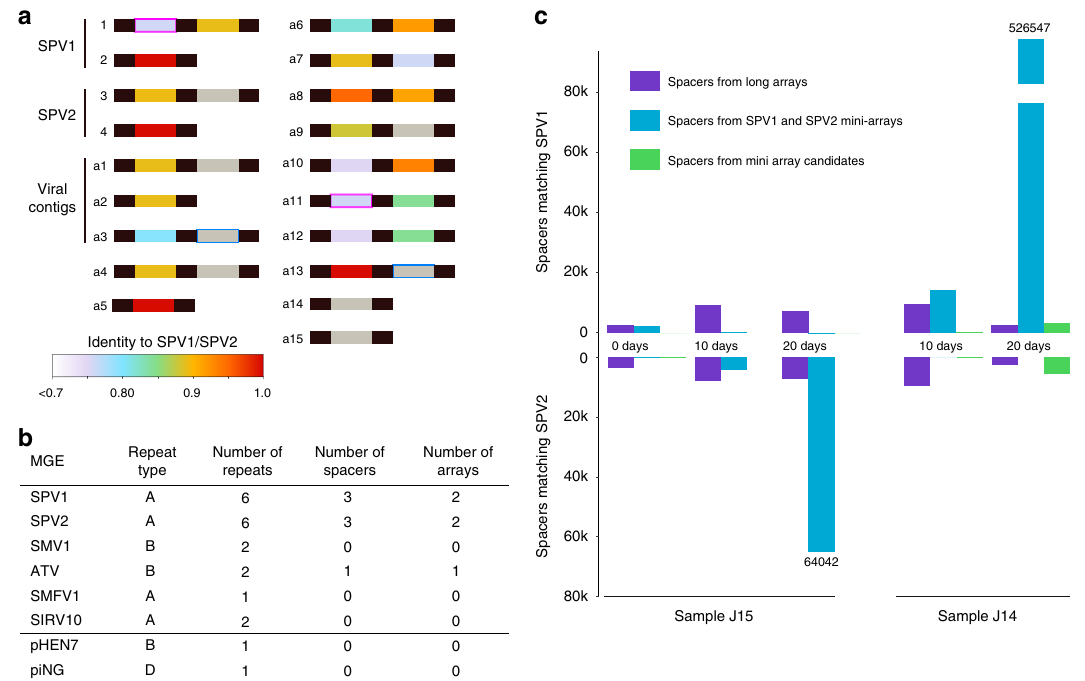
Fig. 5 Mini-CRISPR arrays in viral genomes. a mini-CRISPR arrays predicted from the CRISPRome data (labeled as a1 through a15). Identity of spacers to SPV1 or SPV2 genomes is color-coded with the scale provided at the bottom of the fi gure. Mini-CRISPR arrays found in SPV1, SPV2 and 3 viral contigs shown in Fig. 3b are labeled on the left. Pink and blue boxes show two pairs of identical spacers. b Mini-CRISPR arrays and standalone repeats in Sulfolobales viruses and plasmids. c Total abundance of SPV1 and SPV2 matching spacers from long (cellular) CRISPR arrays and mini-CRISPR (viral) arrays from SPV1 and SPV2 as well as minor SPV strains. Source data are provided as a Source Data fi